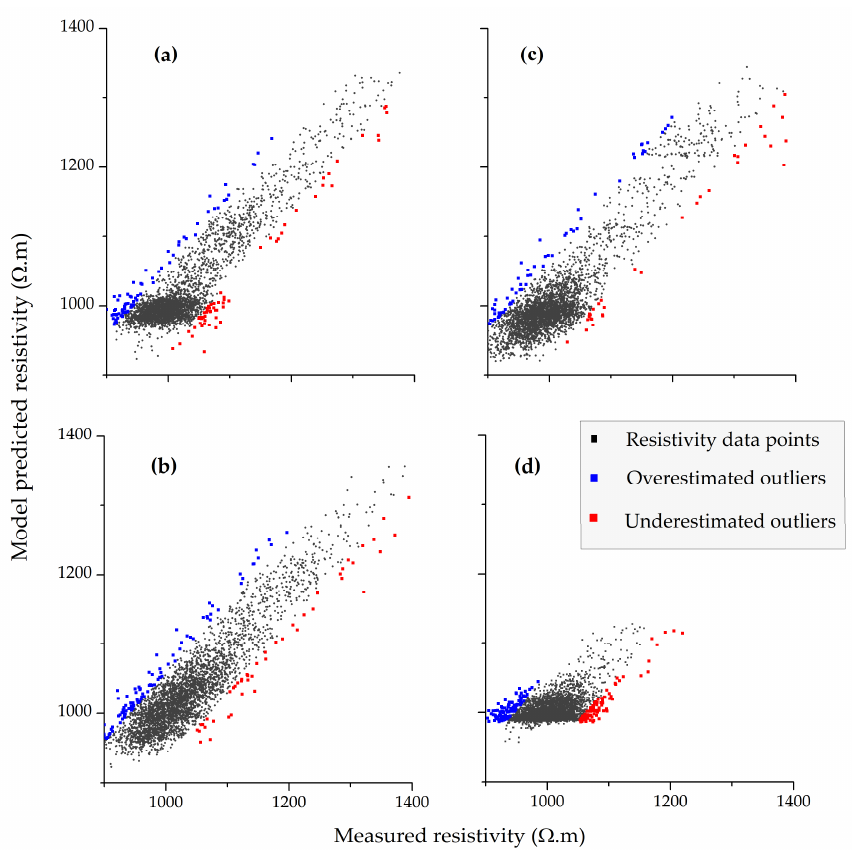
Figure 4. The scatter plot of the model predicted and synthetically measured apparent resistivity data for the arrays: ( a ) dipole-dipole (DD) array, ( b ) pole-dipole (PD) array, ( c ) Wenner–Schlumberger (WS) array, and ( d ) pole-pole (PP) array. Overestimated and underestimated data outliers are displayed on the upper and lower boundaries.